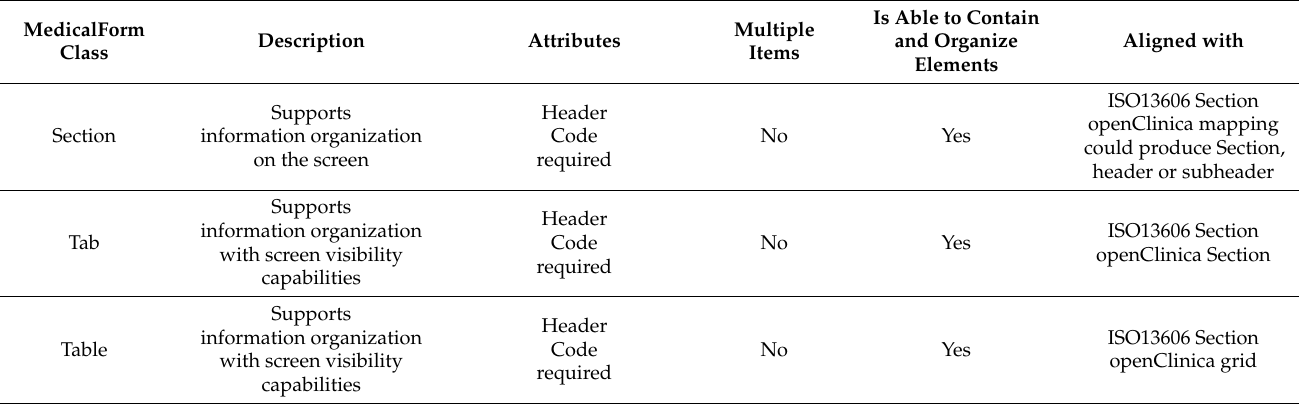
Table A2. MedicalForm element attributes and mapping to standards and openClinica